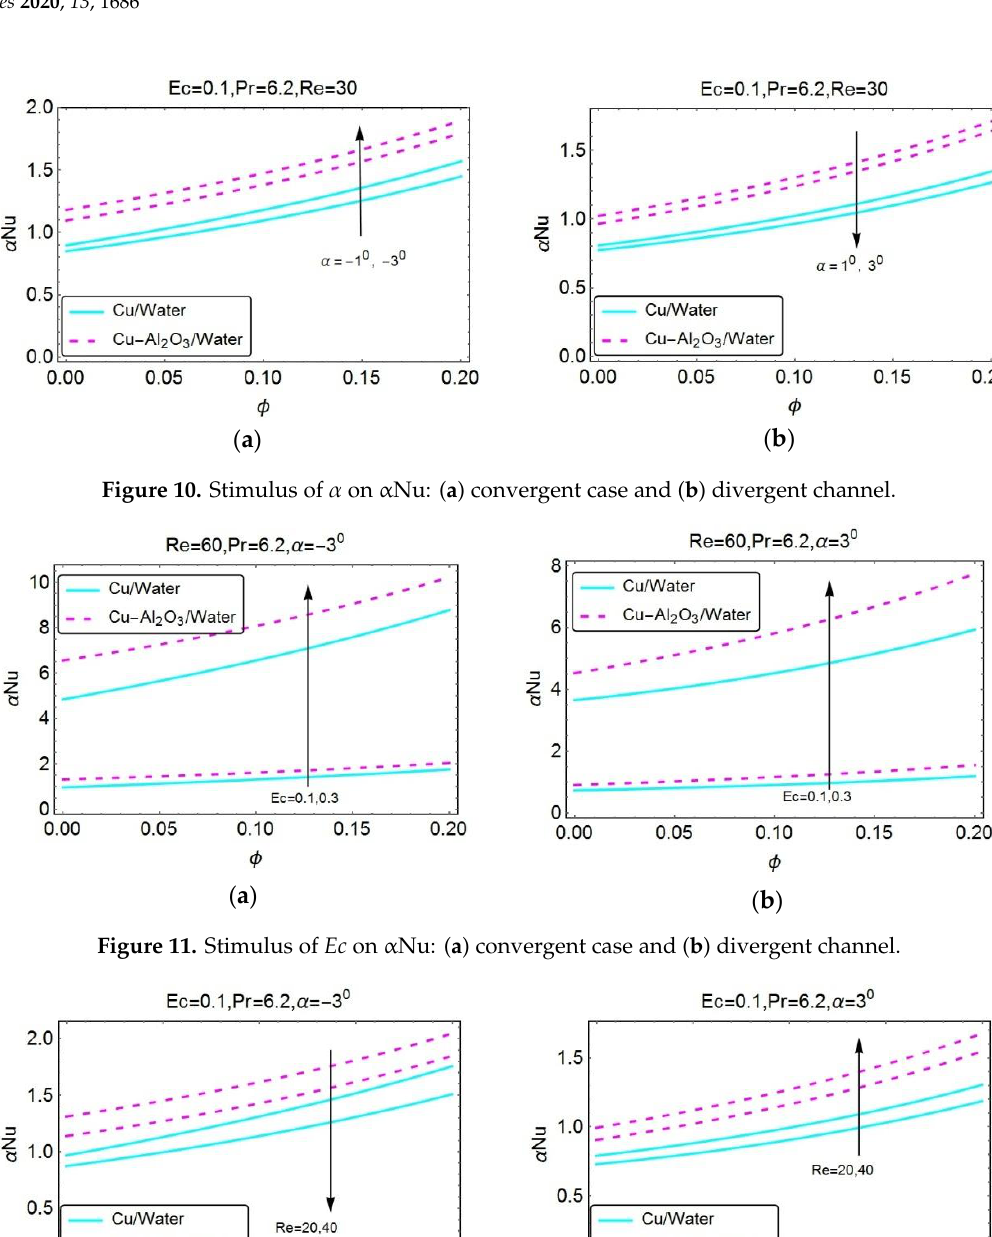
( b ) Figure 8. Stimulus of Ec on Θ(η) : ( a ) convergent case and ( b ) divergent channel. ( a ) ( b ) Figure 9. Stimulus of Re on Θ (η) : ( a ) convergent case and ( b ) divergent channel. Alterations in heat transfer rate are of great importance due to many industrial and technological uses. The various flow parameters play a significant role in local heat transfer rate (Figures 10–12). From Figure 10 it is obvious that more heat transfers at the walls for the narrowing channel. For the diverging case these influences reverse. Water containing Cu–Al 2 O 3 has the capability to transfer more heat at the channel walls compared to that of Cu/water. On the other hand, Eckert number favors the heat transfer rate in both opening and narrowing channels. These effects are demonstrated